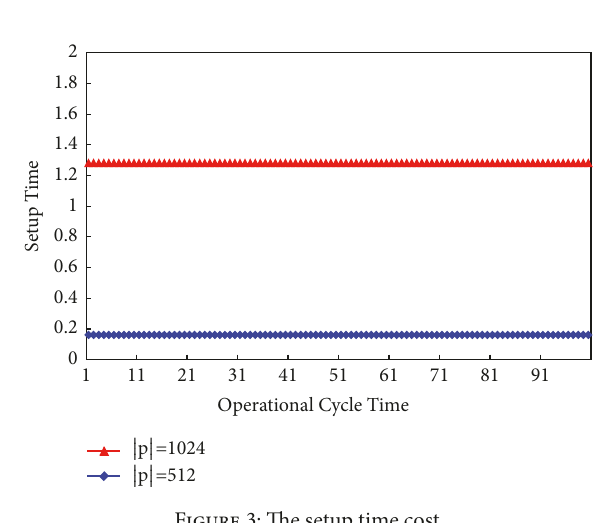
Figure 3: The setup time